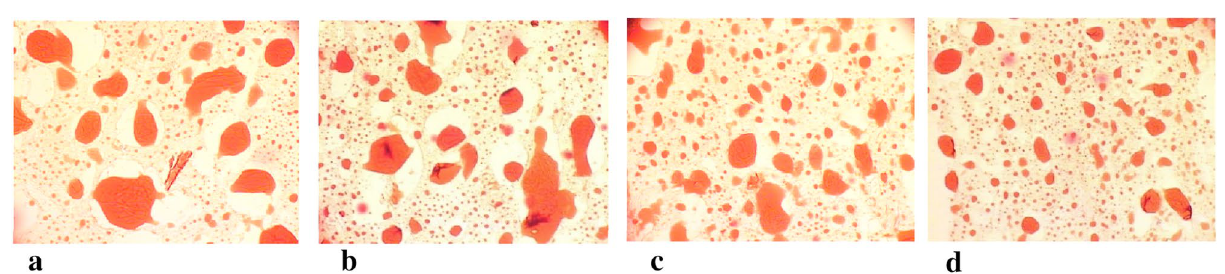
Figure 4. Microstructure of batter (x200) (fat globules) after 10 min chopping produced with varying rotational speed of chopper knives and bowl: ( a ) −1500/10 rpm −1 , ( b ) −1500/20 rpm −1 , ( c ) −3000/10 rpm −1 , ( d ) −3000/20 rpm −1 .